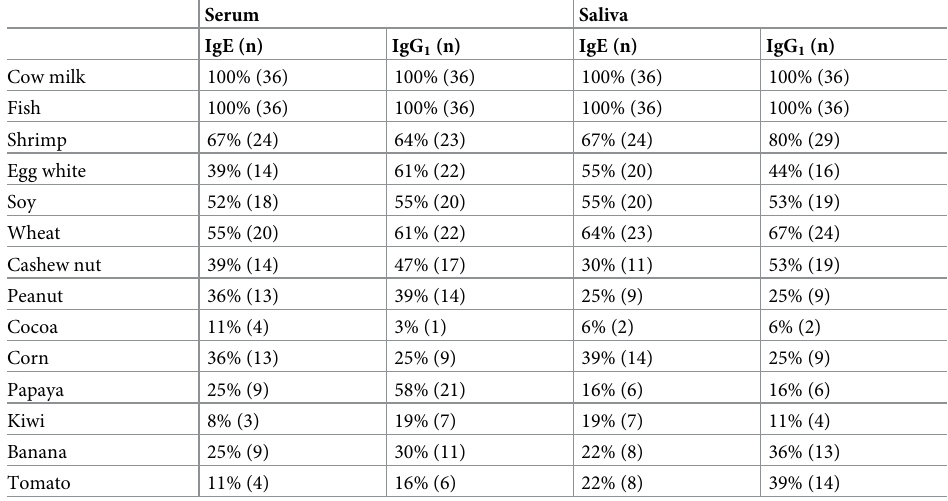
Table 2. Distribution of IgE and IgG 1 present in serum and saliva of allergic children for each food tested by ELISA.